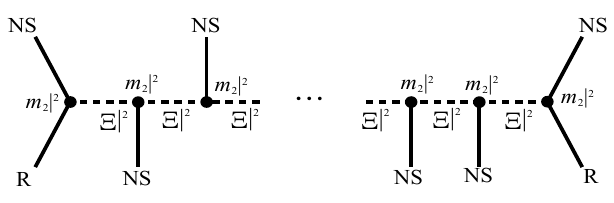
Figure 3 . All nonvanishing diagrams take the form of a line of propagators connecting a vertex with an NS and R external state to a vertex with an NS and R external state. The propagators are connected with vertices containing one NS external